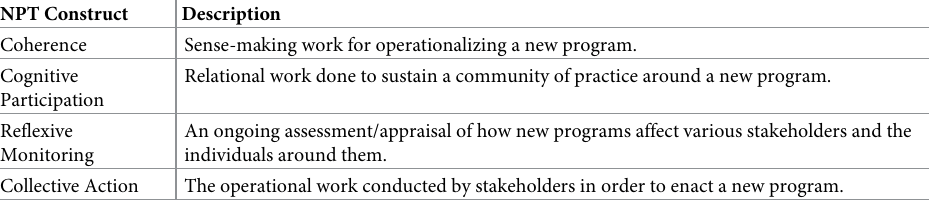
Table 6. A Description of each core construct of Normalization Process